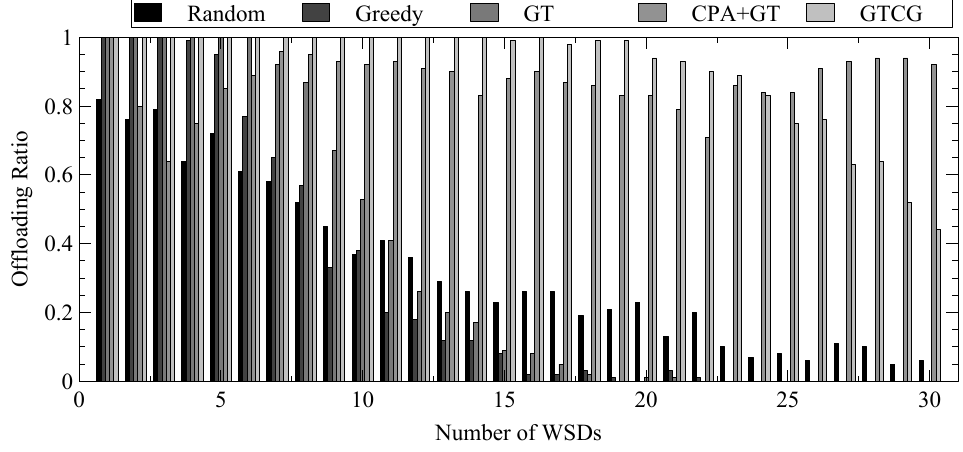
Figure 9. Offloading Ratios for Different Number of WSDs.